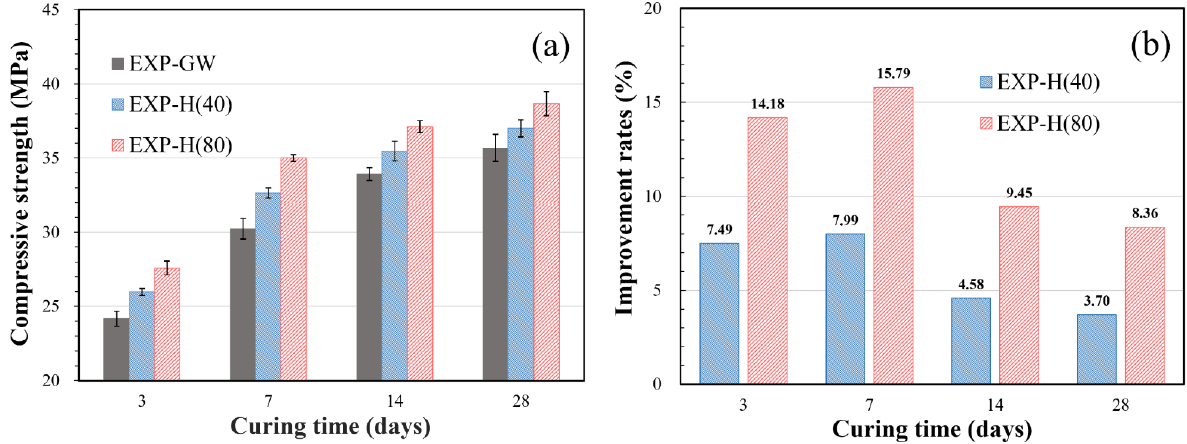
Figure 6. Compressive strength of cement mortar: ( a ) comparison of average compressive strength; ( b ) improvement rates of compressive strength compared to EXP-GW.